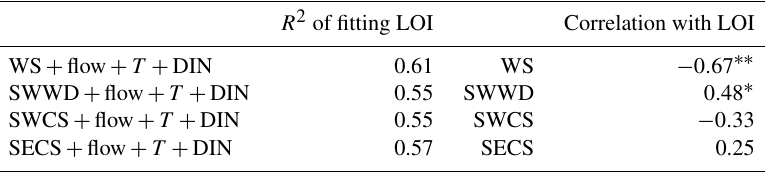
Table A3. Coefficients of determination ( R 2 ) for average wind speed (WS), southwestern wind duration (SWWD), southwestern wind cumulative stress (SWCS), and southeastern wind cumulative stress (SECS) in fitting LOI; Pearson correlation coefficient of WS, SWWD, SWCS, and SECS with LOI.